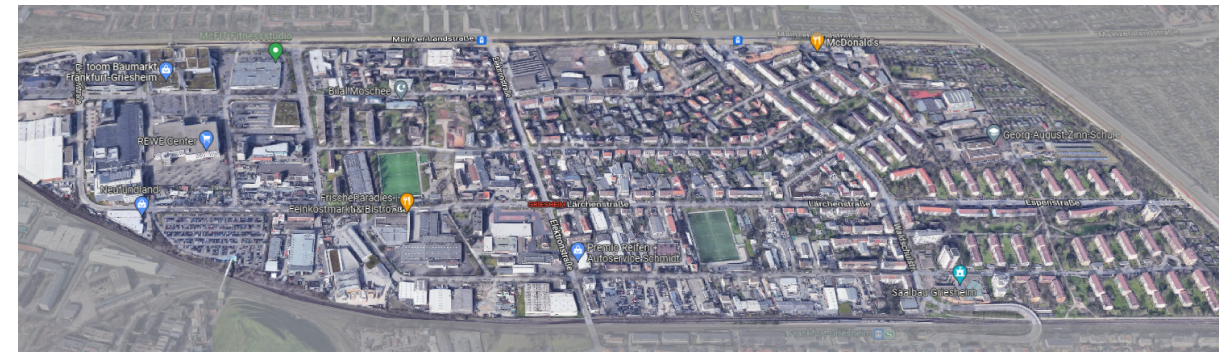
Figure 10. An aerial view of Griesheim-Mitte [42].